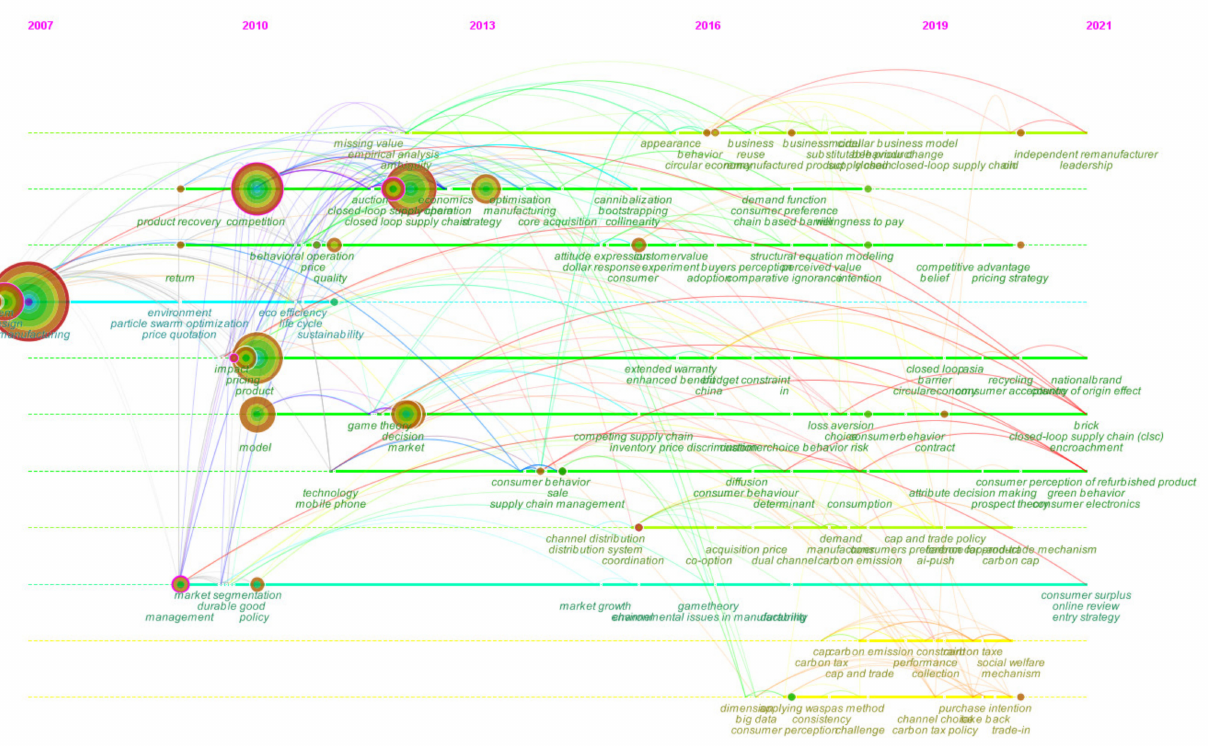
Figure 6. Timeline map of